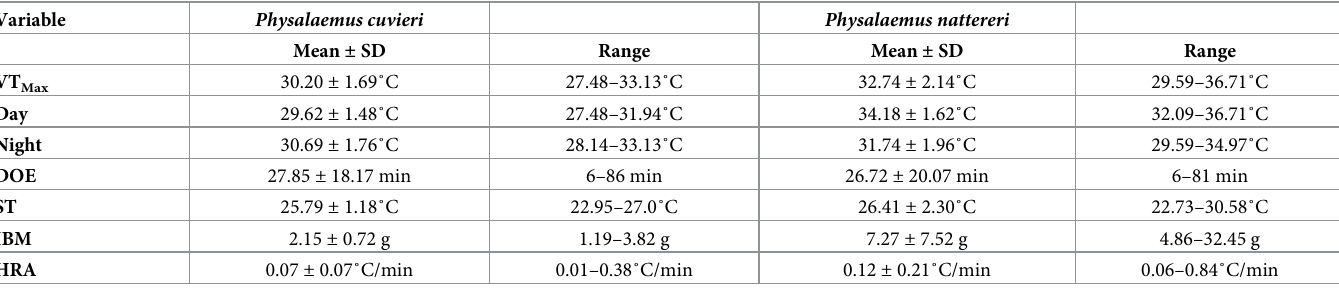
Table 1. Variation of the VT Max and predictor variables for P . cuvieri and P . nattereri from Estac¸ ã o Ecolo´gica de Santa Ba´rbara, state of S ã o Paulo, Brazil.